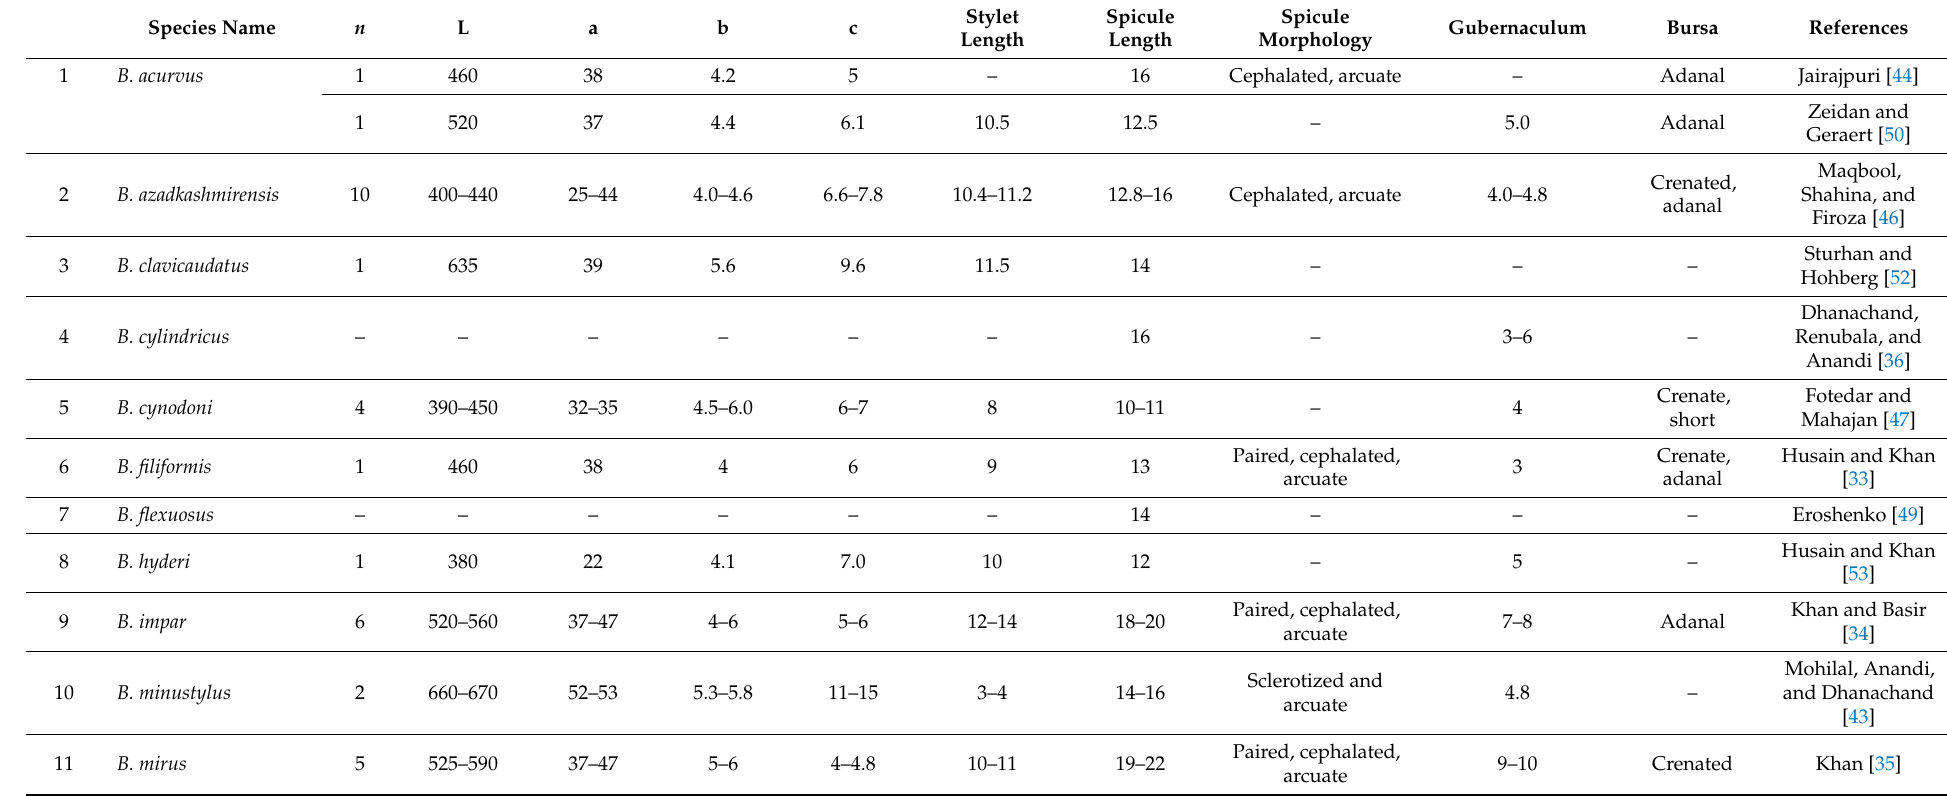
Table 2. Main morphological characters and morphometrics of male Boleodorus species. All measurements are in µ